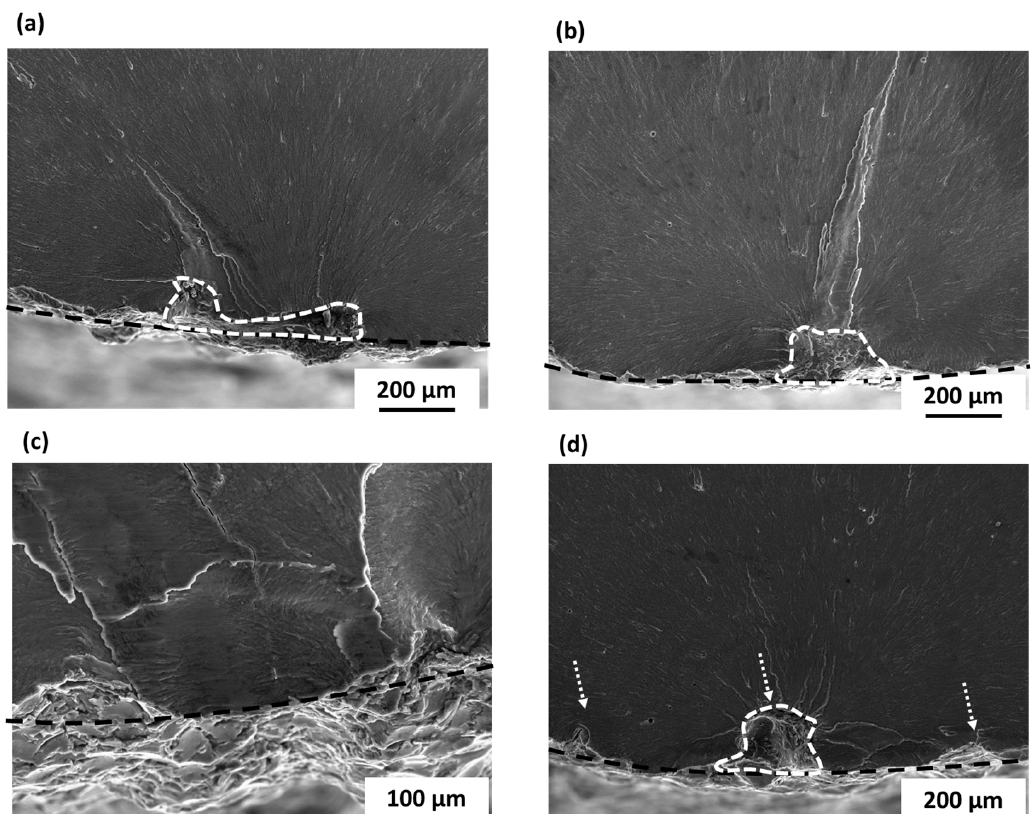
Figure 7. SEM observations ( a ) Z sample, as-built surface roughness and lack-of-fusion-type defect, σ max = 80 MPa, Nf = 330,000 cycles, ( b ) Z sample, lack-of-fusion-type defect, 90 MPa, 180,000 cycles, ( c ) XY sample, as-built surface roughness, 80 MPa, 275,000 cycles and ( d ) alpha45, sub-surface surface defect, 90 MPa, 90,000 cycles.